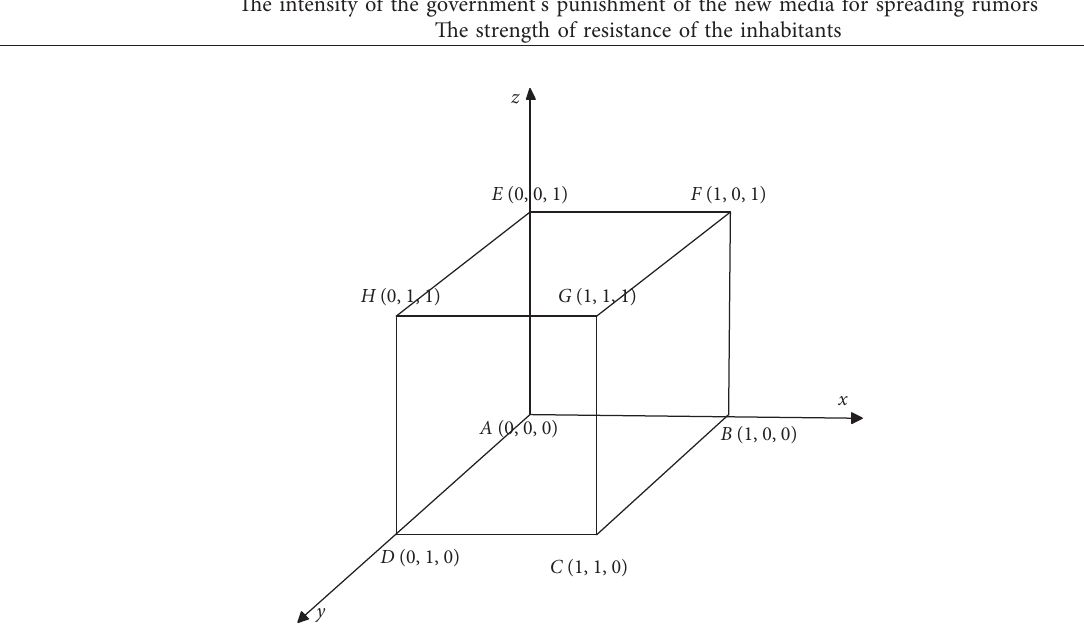
Figure 1: Schematic diagram of three-dimensional representation of strategy selection of game players. Table 2: Revenue function under corresponding strategies.